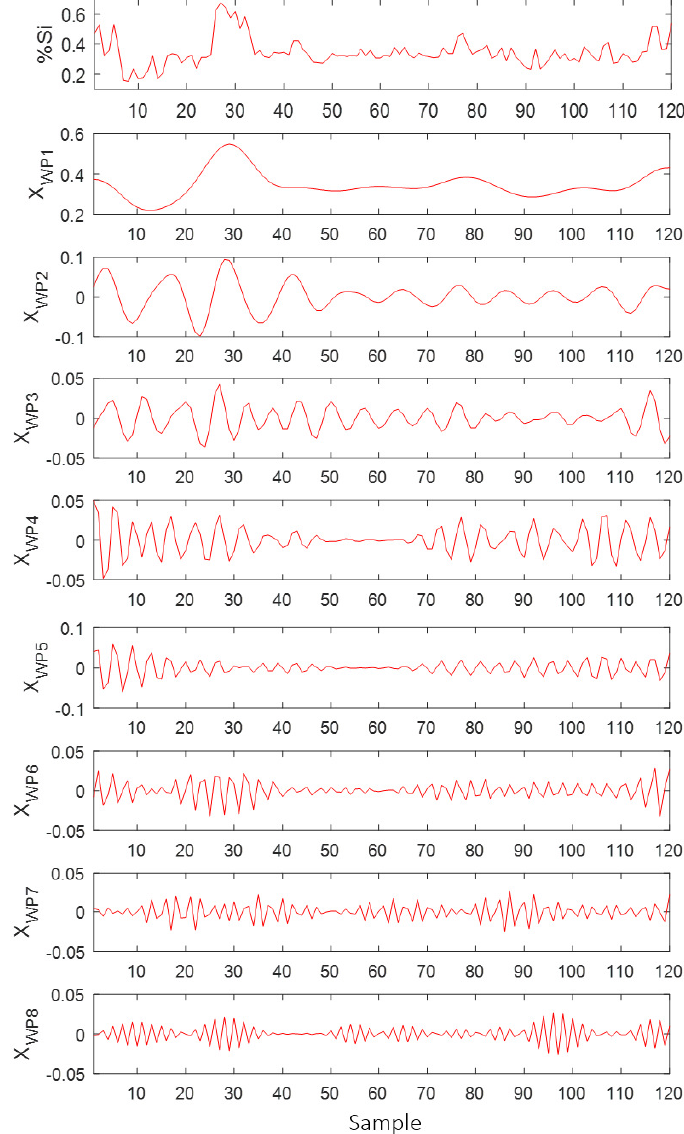
Figure 5. MODWT decomposition of silicon content time